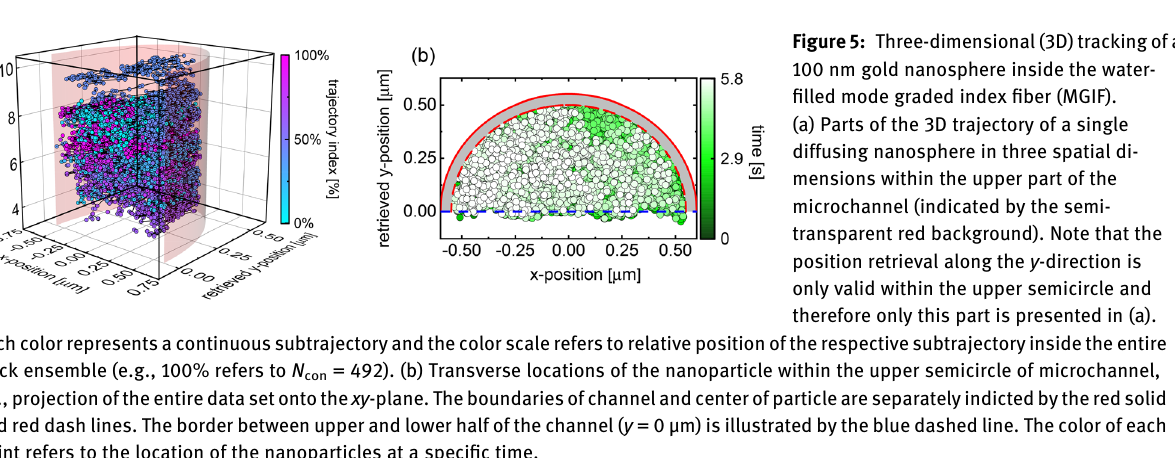
Figure 5a shows the continuous parts of the trajectory of the nanosphere that are solely located in the upper semi- circle. Here each subtrajectory is shown in one single color. The number of continuous trajectories of the nanoparticle in the upper semicircle is N = 492, while the averaged con and maximum number of frames per continuous trajectory are N = 16 and N = 262. ave max